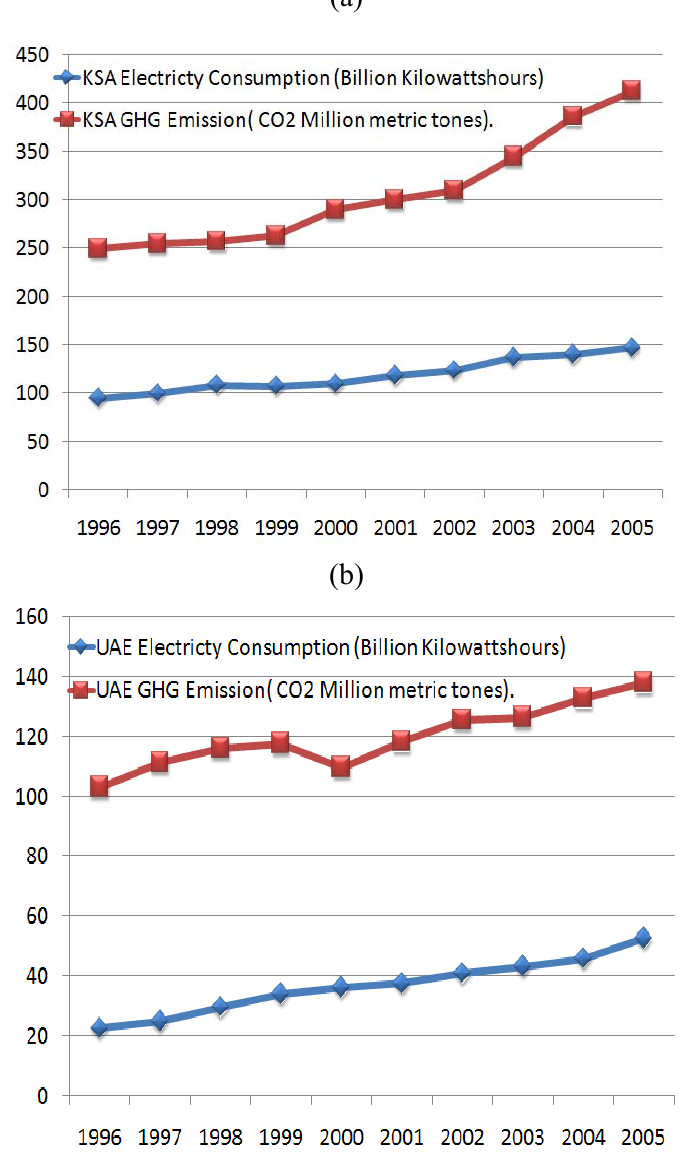
Figure 5. (a). UAE CO and electricity